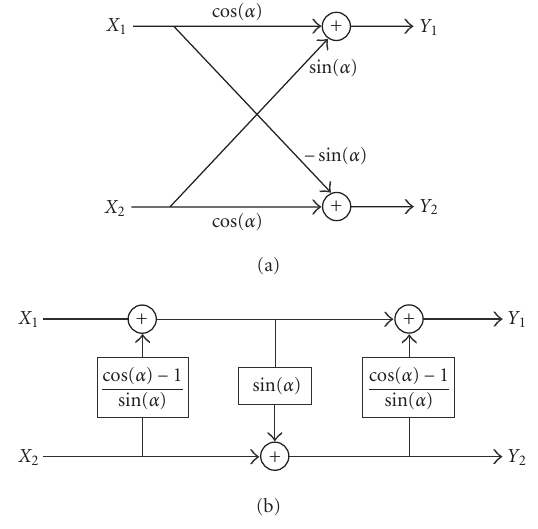
Figure 2: Signal flow graph of (a) the plane rotation and (b) the plane rotation with three lifting